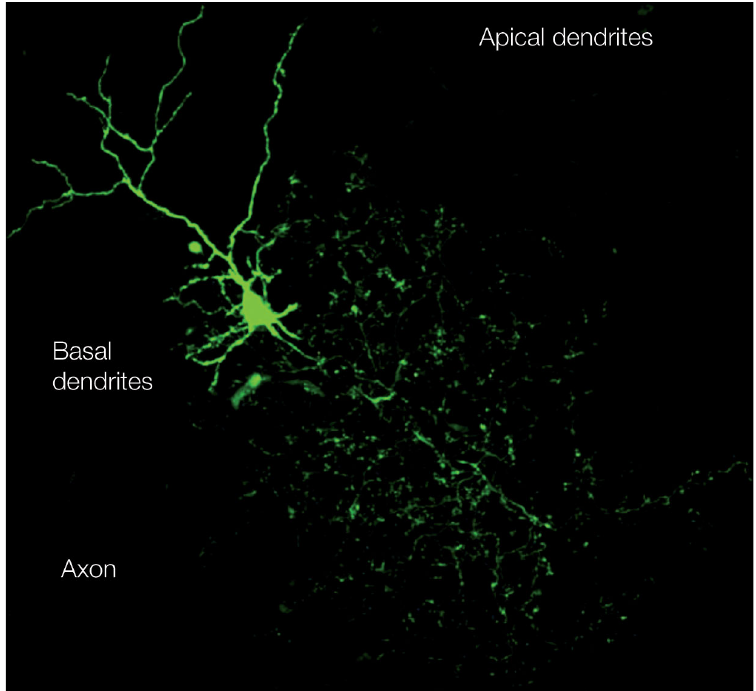
Figure 1 | The Golgi cell. The image of a Golgi cell fi lled with AlexaFluo through a patch-clamp pipette (removed) in an acute cerebellar slice is reconstructed with a confocal microscope (stack view). It can be noted the broad extension of the axonal plexus, the multiple short basal dendrites and two apical dendrites climbing into the molecular layer (kindly provided by Guillaime Dugué and Stephane